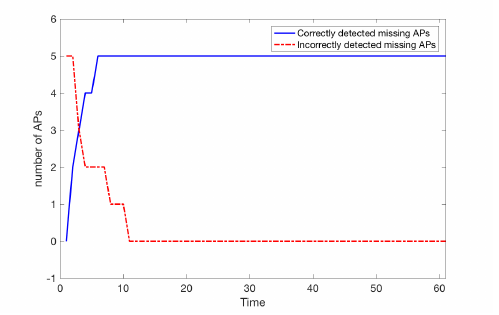
Figure 13. Number of missing APs detected (5 APs are not working and 5 APs are turned on again).